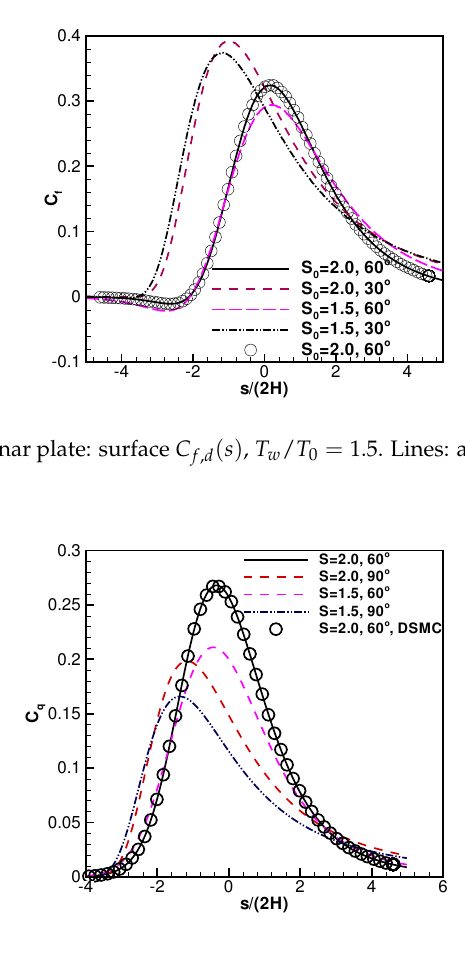
Figure 10. Diffuse planar plate: surface C q , d ( s ) , T w / T 0 = 1.5. Lines: analytical; symbols: